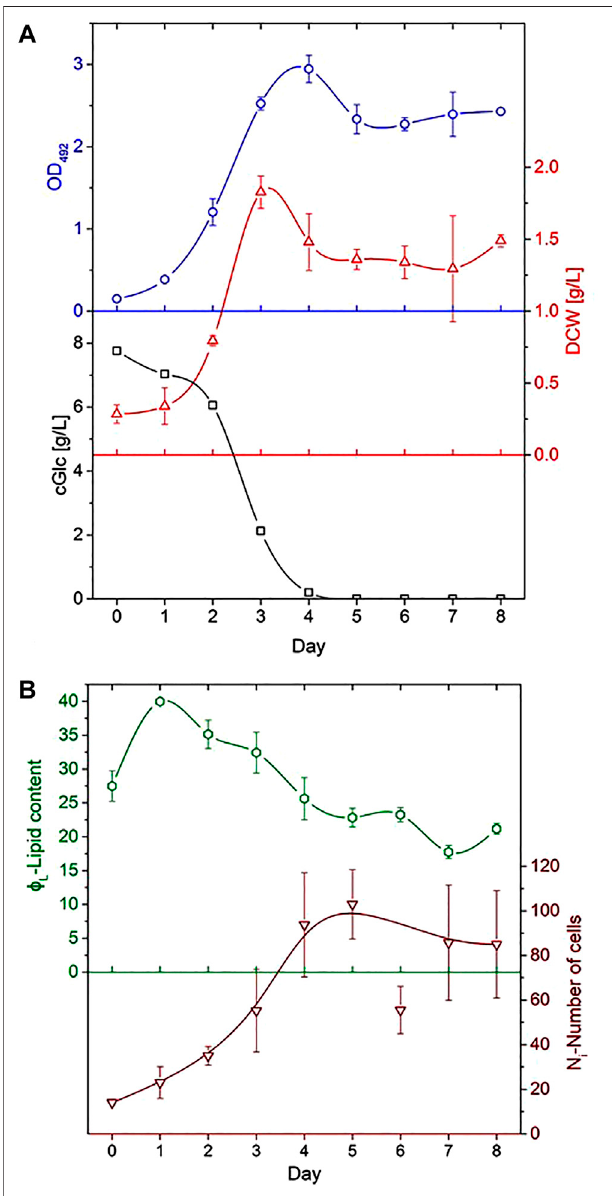
FIGURE 2 | Process-analytical parameters as a function of day of cultivation. (A) Optical density OD as measured at 492 nm (top), dry cell weight DCW (middle) and glucose concentration CGL evaluated from the supernatant (bottom). (B) Plot of the average lipid content ϕ L (top) and numberofcells N i asanalysedforthedeterminationoflipidcellsizedistribution (bottom). Error bars derived from the data variations in different runs; lines indicate the trend of data.